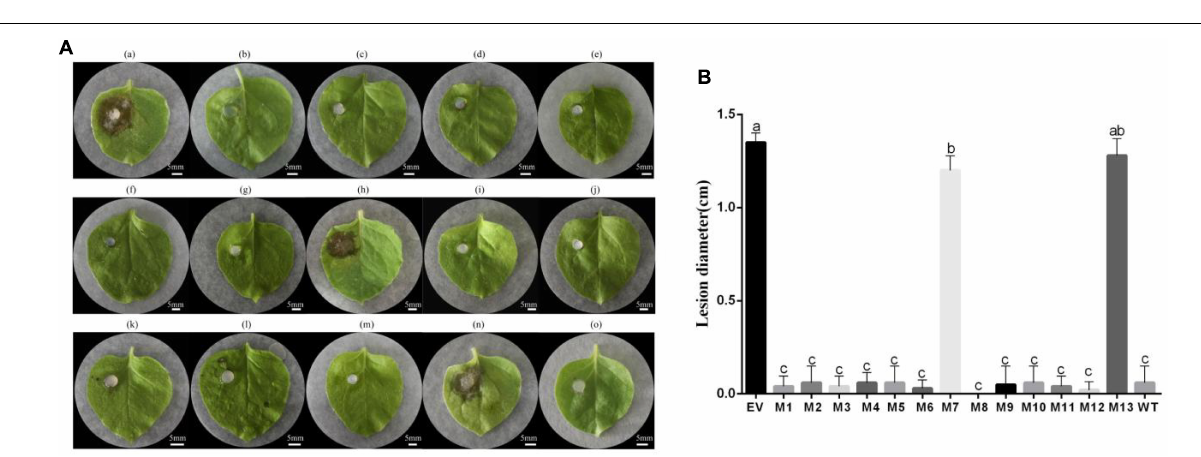
of G307A/T308A and S213A/L214A/G215A impaired